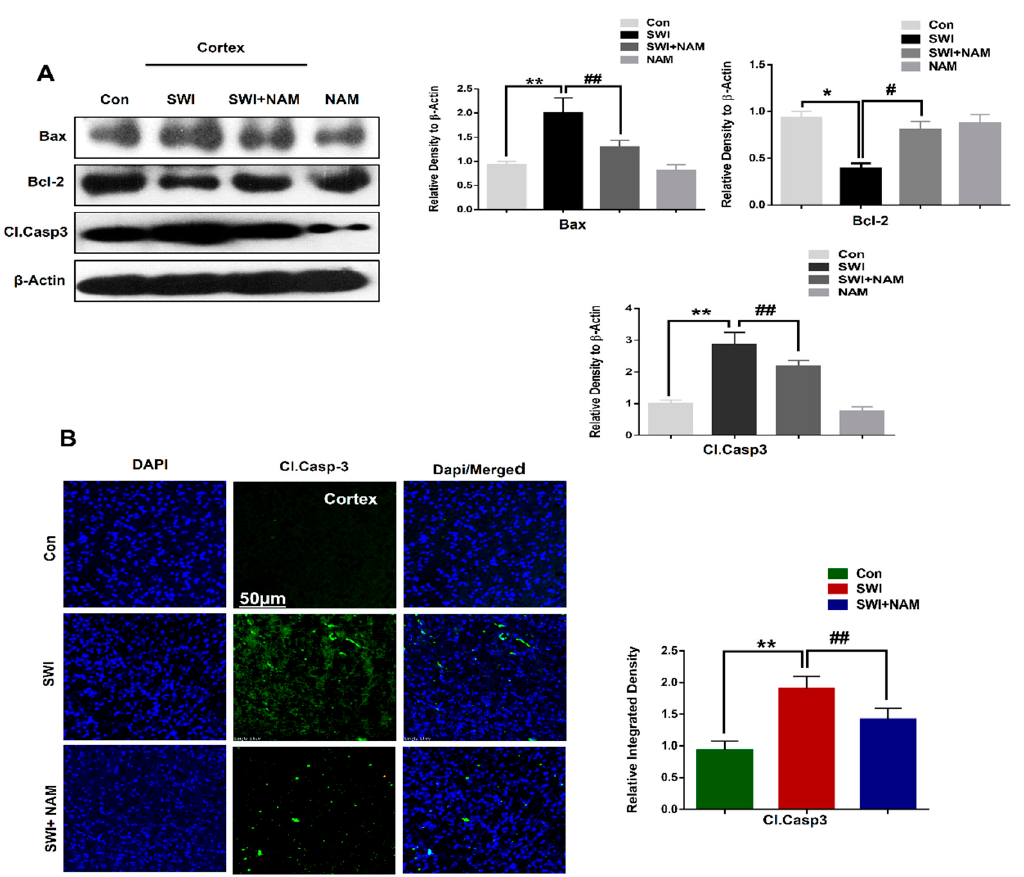
Figure 5. NAM treatment reduced the apoptotic neurodegeneration in brain-injured mice. ( A ) Western blot and histogram showing the expression level of apoptotic markers, such as cleaved caspase-3, Bax, and Bcl-2, in the brain-injured cortex alone and in the NAM-treated mice groups. The bands were quantified using Sigma Gel software. ( B ) Confocal microscopy images showing the caspase-3 immunoreactivity (Magnification X10). The caspase-3 fluorescence integrated density was analyzed with imageJ software. Values were calculated through ImageJ software. All values were taken from three independent experiments. Statistical analysis was done via one-way ANOVA, followed by post hoc analysis. P < 0.05 was considered to be statistically significant. The symbols * P < 0.05, and ** P < 0.01 represent significant differences between the control and SWI; # P < 0.05, and ## P < 0.01 represent significance differences between the SWI and SWI plus